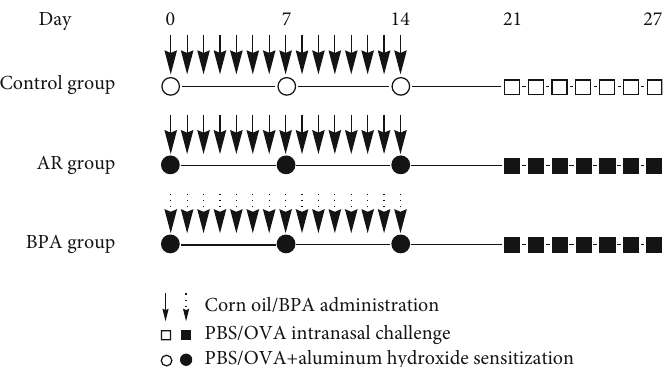
Figure 1: The experimental protocol. OVA sensitization was followed by OVA challenge to trigger AR development. Brie fl y, on days 0, 7, and 14, mice in the OVA and BPA groups were sensitized with 2mg of aluminum hydroxide (100 μ L of solution) and OVA (100 μ g) via intraperitoneal injection; control mice received PBS alone. Mice in the BPA group were subcutaneously injected with 0.5mg/kg/day BPA in corn oil on days 0 – 14; the other two groups received only corn oil. The OVA and BPA groups were intranasally challenged with 100 μ g OVA in 20 μ L PBS on days 21 – 27. The control group received PBS alone. OVA: ovalbumin; AR: allergic rhinitis; BPA: bisphenol A; PBS: phosphate-bu ff ered